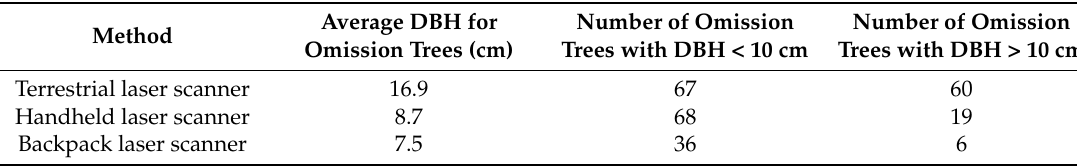
Table 6. The average diameter at breast height (DBH) for omission